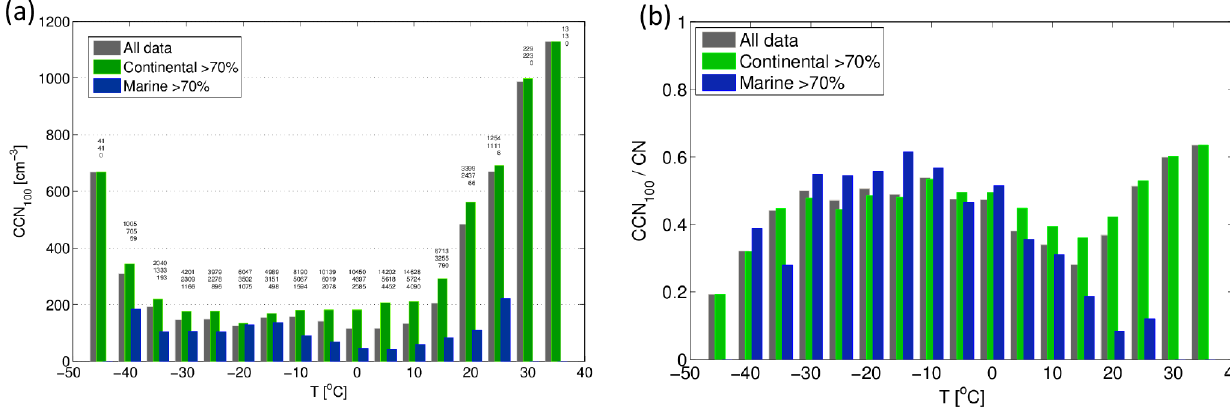
Figure 11. Panel (a) : average CCN 100 concentration as a function of measurement temperature. Different bars present cases calculated using all data (dark grey), continental data (green), and marine data (blue). Reading from top to bottom, the numbers above each bar show the amount of DMPS data available for each total and for continental and marine cases; these numbers are the same for panel (b) . Panel (b) : average CCN 100 to condensation nuclei (CN) ratio as a function of measurement temperature. Different bars represent cases calculated using all data (dark grey), continental data (green), and marine data